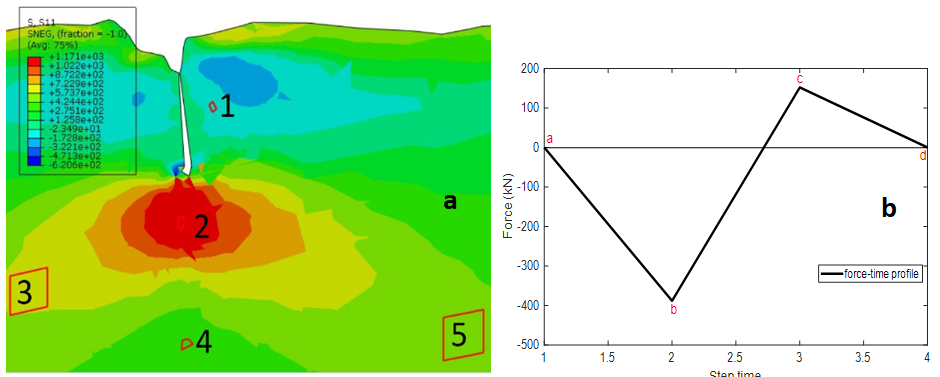
Figure 20. ( a ) Locations of five different elements close to and far from the crack, ( b ) loading time profile.